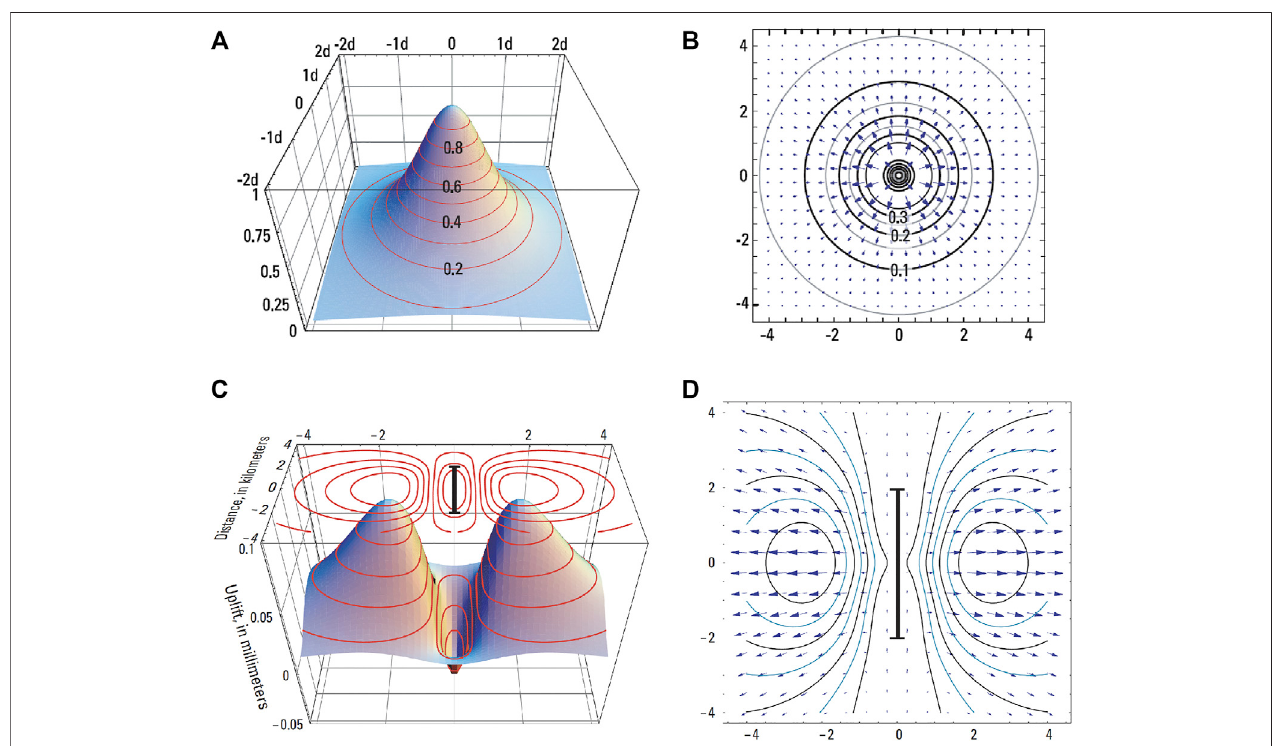
FIGURE 2 | (A) and (B) Vertical (oblique view; left) and horizontal (map view; right) ground deformation pattern induced by a source with radial symmetry, responsible for magma accumulation; the source of deformation lies belowthe most uplifted area. (C) and (D) Vertical (oblique view; left) and horizontal(map view; right) ground deformation pattern induced by a source with non-radial symmetry (dyke), responsible for magma propagation; the source of deformation lies below the black bar (modi fi ed after Lisowski,